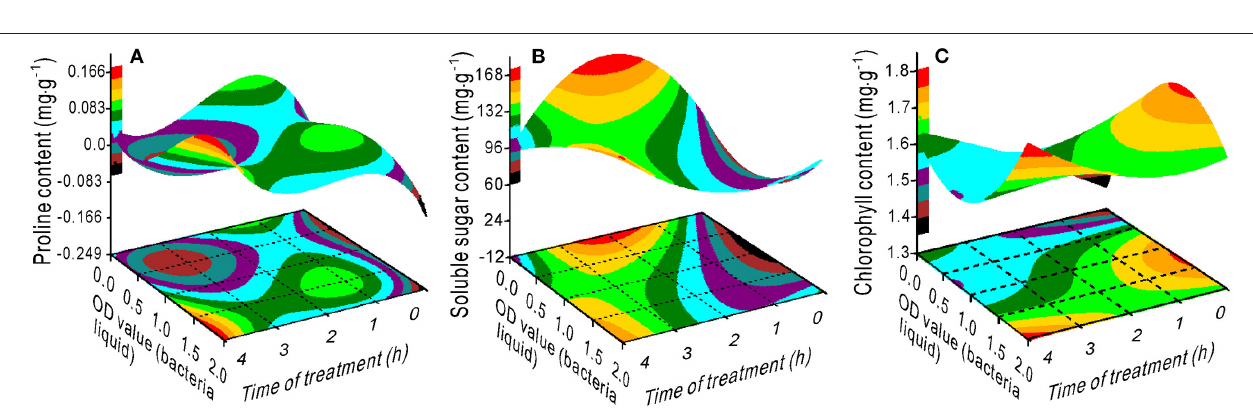
FIGURE 4 | Response surface plots showing the interaction between the bacterial liquid and treatment time on the proline (A) , soluble sugar (B) , and chlorophyll (C) contents.